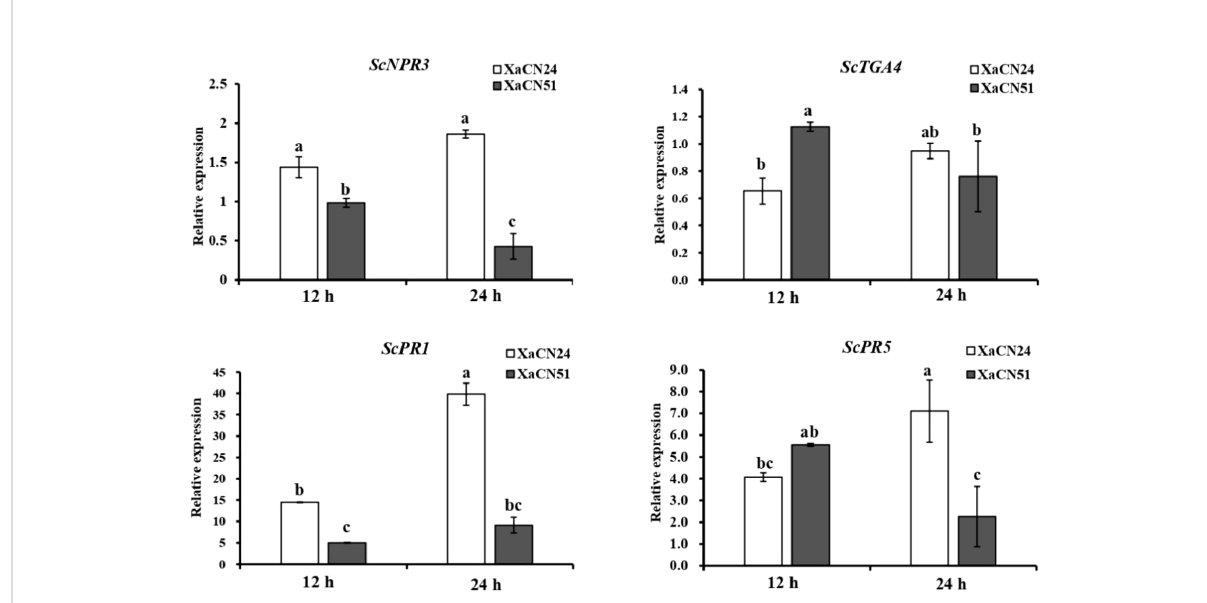
FIGURE 7 Expression pattern of salicylic acid (SA) signaling pathway related genes in sugarcane leaves inoculated with two strains of Xanthomonas albilineans (XaCN24 and XaCN51). Each vertical bar represents the mean ± standard deviation of three leaf subsamples collected 12 and 24 hours after inoculation and three technical replicates per subsample. Each leaf subsample is issued from a pooled sample of fragments collected from 35 inoculated leaves. Means with the same letter are not signi fi cantly different at P = 0.05 according to Duncan ’ s